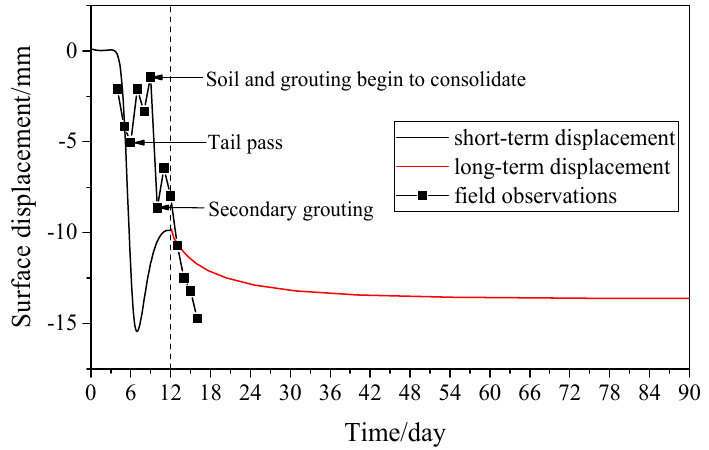
Figure 6. Schematic diagram of shield tunnel excavation. Figure 6. Simulated and monitored surface displacement time-history